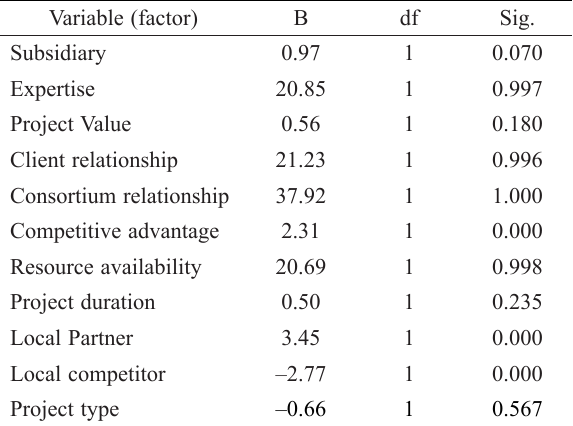
Table 4. Cross tabulation results (0: bid failure, 1: bid success) Table 5. Factors (variables) levels of